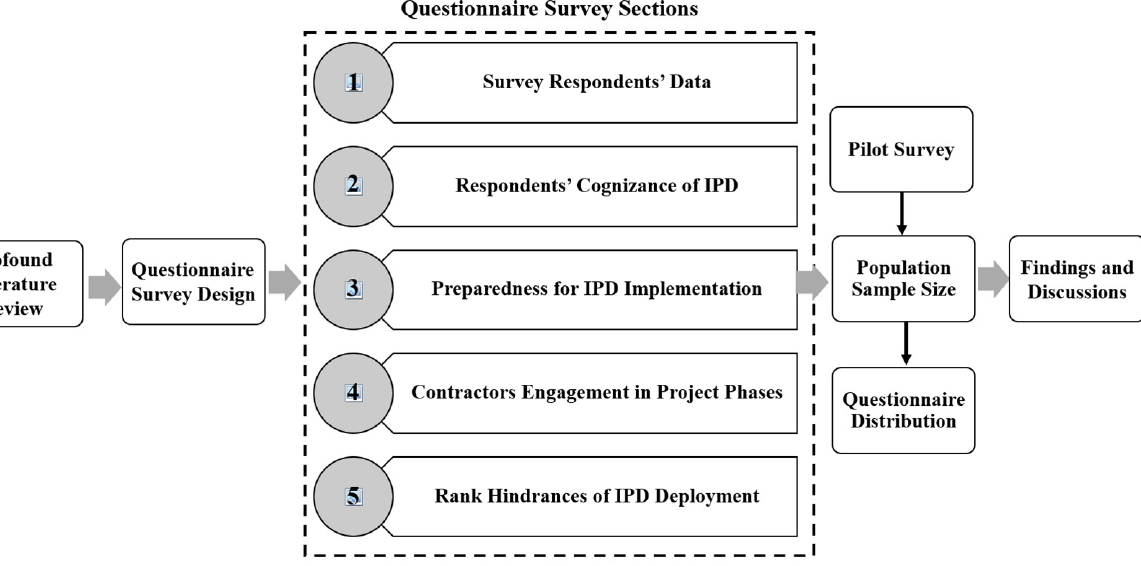
Table 1. Question points constituted in the questionnaire survey.